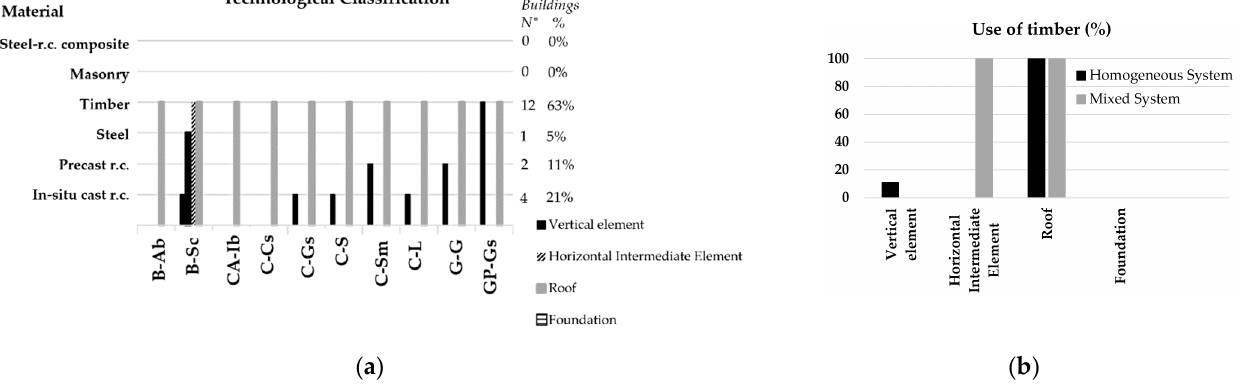
Figure 10. Section 1A CARTIS-Building: ( a ) Technological classification; ( b ) Use of timber for the structural elements.